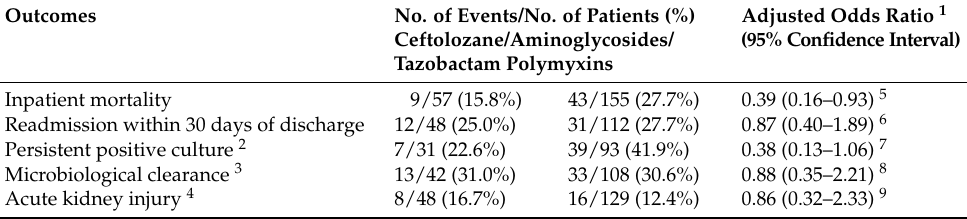
Table 3. Comparative effectiveness of ceftolozane/tazobactam compared with aminoglycoside or polymyxin treatment regimens among hospitalized patients with positive MDR Pseudomonas aeruginosa